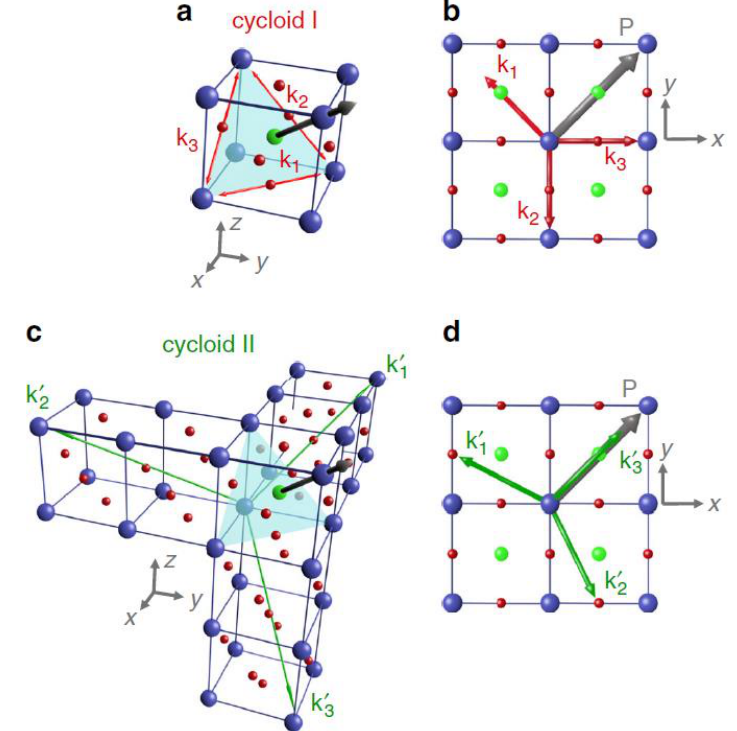
Figure 5. Schematic representation of spin cycloids in ( a ) Bulk, ( c ) In thin films, ( b ) gives the projection of cycloid k vectors along a plane oriented at (001) plane. ( d ) Gives the projection of spin cycloid k’ vectors in the thin film along (001) orientation. As seen in Reference [61].